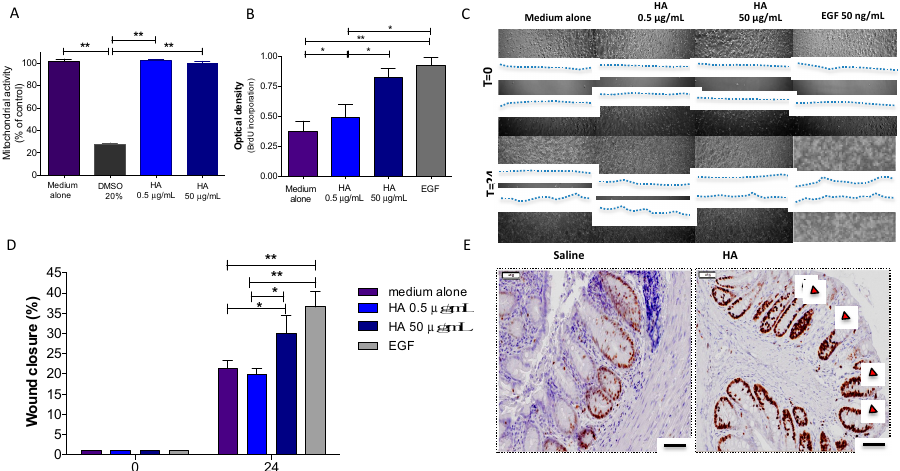
Figure 3. HA treatment promoted epithelial cell proliferation. ( A ) Effect of HA on the viability of Caco-2 cells determined by using the 2,3-bis (2-methoxy-4-nitro-5-sulfophenyl)-2H-tetrazolium-5-carboxanilide inner salt assay. Cells were treated with two different doses of HA (0.5 and 50 μ g/mL) or 20% DMSO (as negative control) and incubated for an additional 24 h. ( B ). The effect of HA on cell proliferation measured by a BrdU cell proliferation assay. Cells were treated with two different doses of HA (0.5 and 50 μ g/mL) or epidermal growth factor (EGF) (50 ng/mL, as positive control) and incubated for 24 h. ( C – D ). Representative images and quantitation of the wound closure in Caco-2 cells after incubation with HA (0.5 and 50 μ g/mL) or EGF (50 ng/mL, as positive control) for 24 h. Bars represent the mean ± SEM of a single experiment assayed in triplicate and are representative of the three separate experiments. * p < 0.05 and ** p < 0.01 compared to medium alone. The cell monolayers were photographed at 10x, and the dotted blue lines show the extent of the remaining wound area. ( E ). Paraffin sections of colon from mice receiving HA (1mg/mL) or saline for 72 h after mucosal wounding. The sections were stained for the Ki67 marker (brown signal). Red arrows indicate the proliferation of epithelial cells along the crypt axis. The sections were photographed at 20×; ( n = 5/group); Bar = 50 μ m.